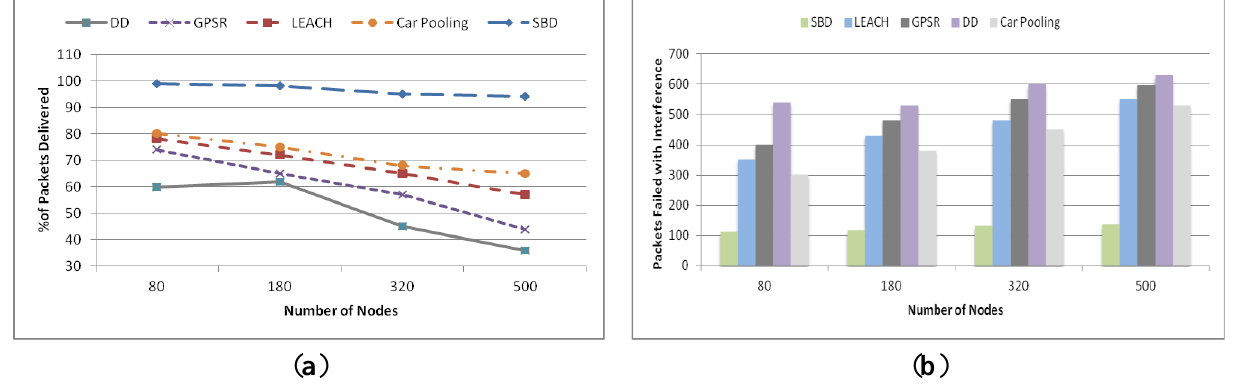
Figure 11. ( a ) Percentage of packets successfully delivered and ( b ) number of packets that failed due to